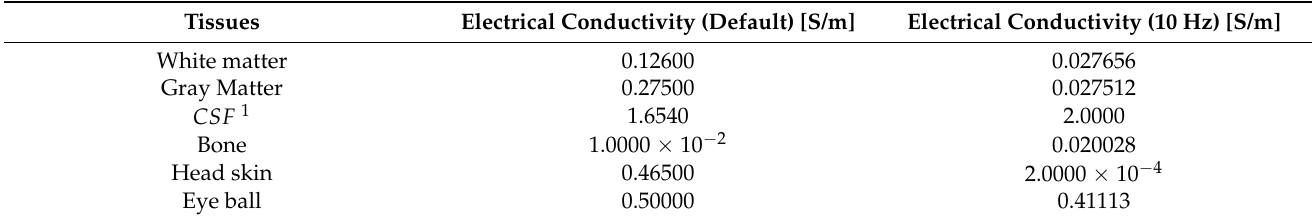
Table 1. Comparison of electrical conductivity between the default value obtained in SimNIBS and the value obtained with 10 Hz stimulation [27,28].